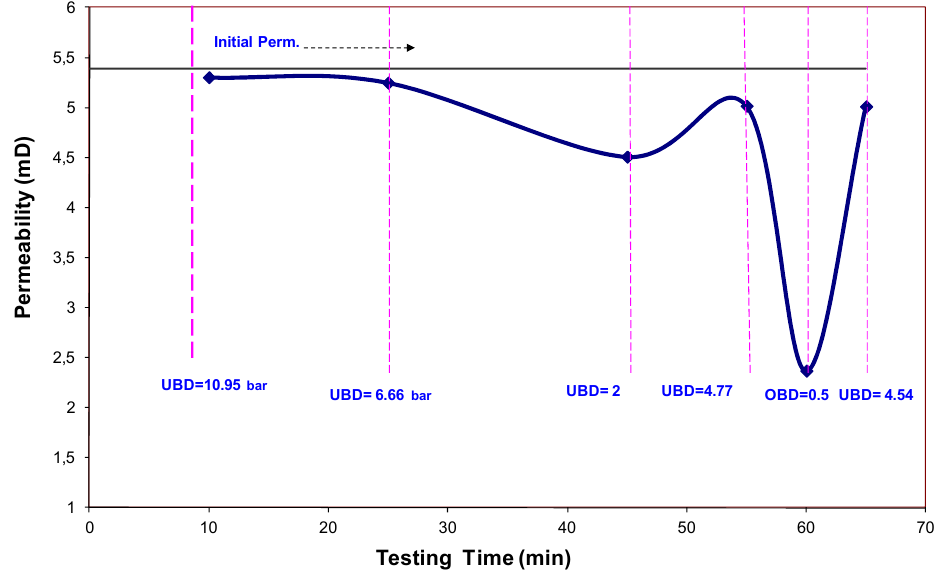
Figure 6. Monitoring of Permeability during UBD leak-off test on sample